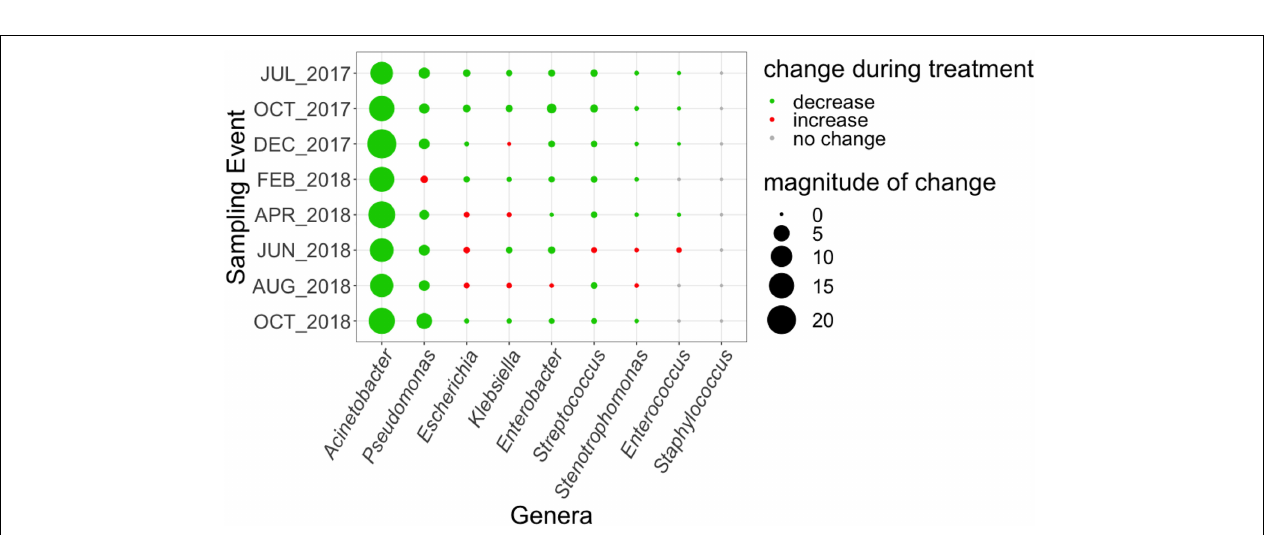
FIGURE 5 | Relative abundance (as percentage) of the top 20 and “other” genera, as annotated using MetaPhlAn2 (Truong et al., 2015) across all 22 samples subject to metagenomic sequencing.